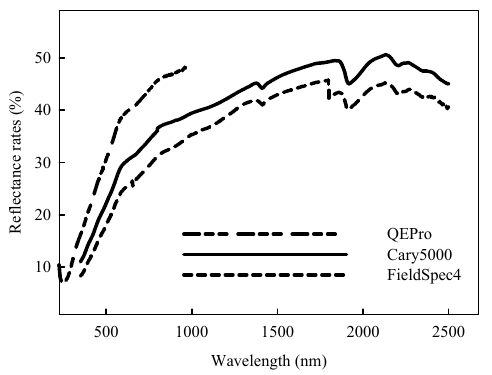
Figure 4. The average reflectance spectra of sediments in Huanghai and Bohai Sea of China by different spectrometers.